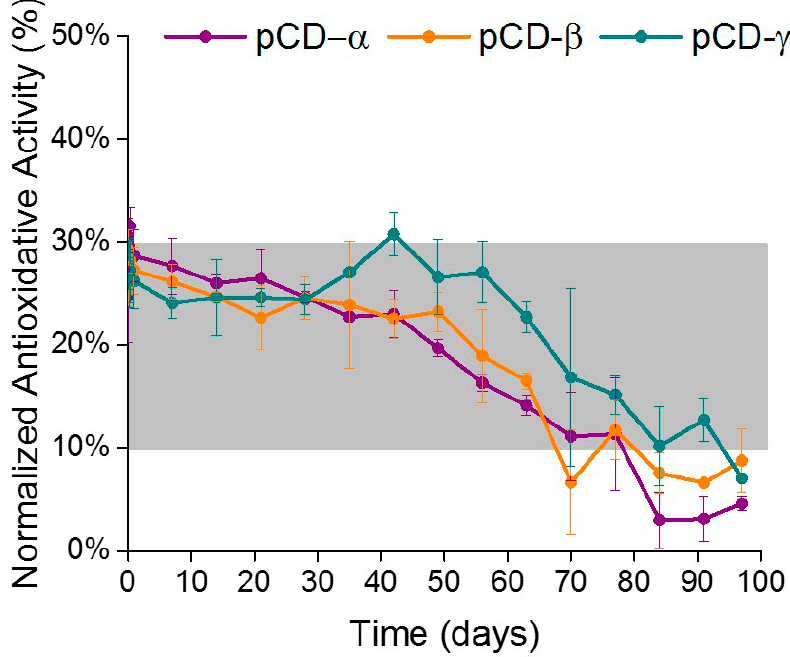
Figure 3. Resveratrol released from pCD shows antioxidant activity in vitro. Resveratrol displays sustained free radical scavenging activity for 50 days in vitro. The scavenging activity decreased over time, correlating to the decrease of resveratrol concentration released from pCD disks. The shaded area depicts the antioxidant activity from a standard curve using 1–100 µg/mL free resveratrol, relating to the concentrations of pCD released resveratrol.